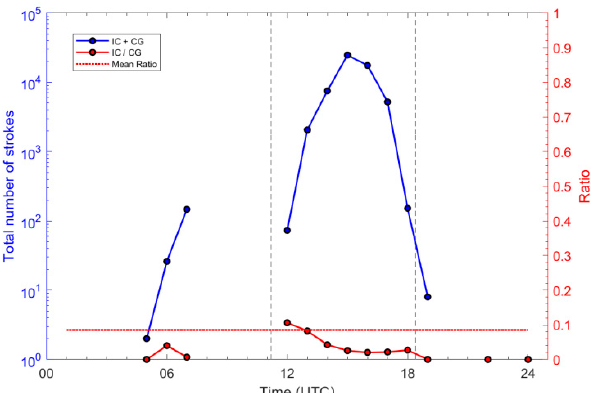
Figure 8. Hourly trend of IC / CG ratio (solid red line) and total number of strokes (blue line) on 2nd September 2018 over a 1 ◦ × 1 ◦ box centred on the GPS antenna. The horizontal red dashed line represents the mean value of the IC / CG ratio over the same 1 ◦ × 1 ◦ box for seven years, from 2012 to 2018.